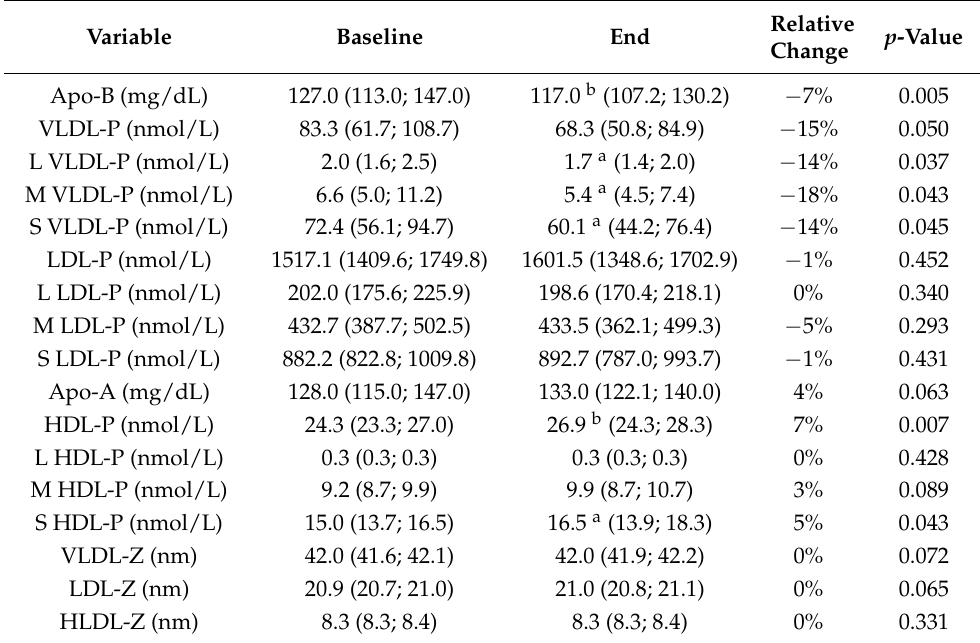
Table 3. Comparison of plasma concentration of apoproteins, lipoproteins and the size of lipoproteins at baseline and after one year of treatment with sub-micron dispersible phytosterols.